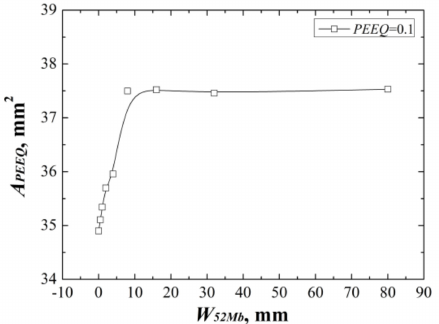
Figure 7. The areas surround by the ε p = 0.1 isoline at the same J -integral for “121” model.